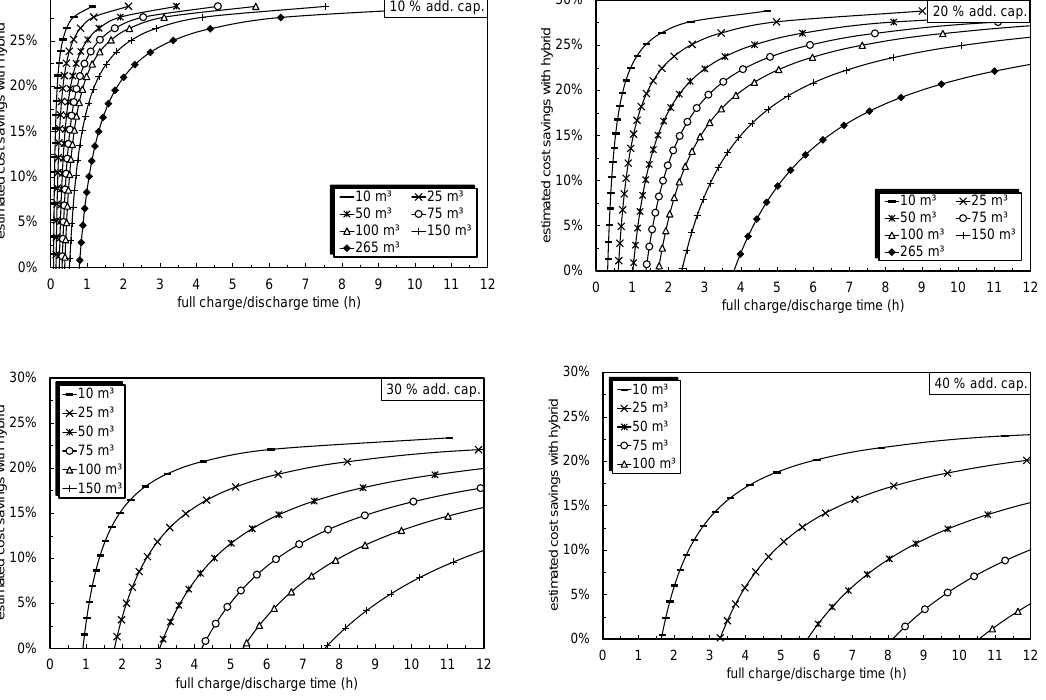
Figure 10. Calculated cost savings with additional capacities of 10%, 20%, 30%, and 40%, and resulting discharge